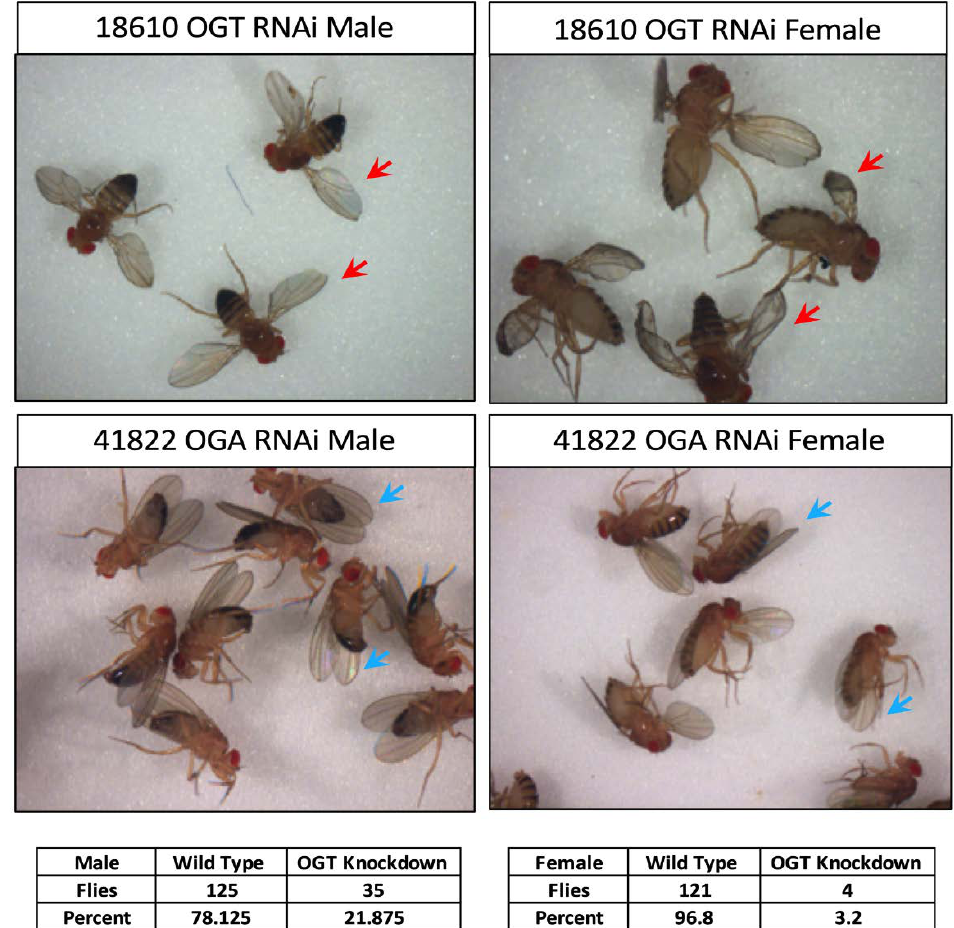
Figure 3. Knockdown of OGT in wing imaginal disc causes a strong phenotype in females. OGT knockdown in wing imaginal discs causes lethality (3% survival, compared to 25% expected) along with wing development defects in females. OGT knockdown in wing imaginal of males did not cause lethality (~22% survival, 25% expected), and males only showed the wings-down phenotype. In comparison, OGA knockdown has no effect on survival and wing development.